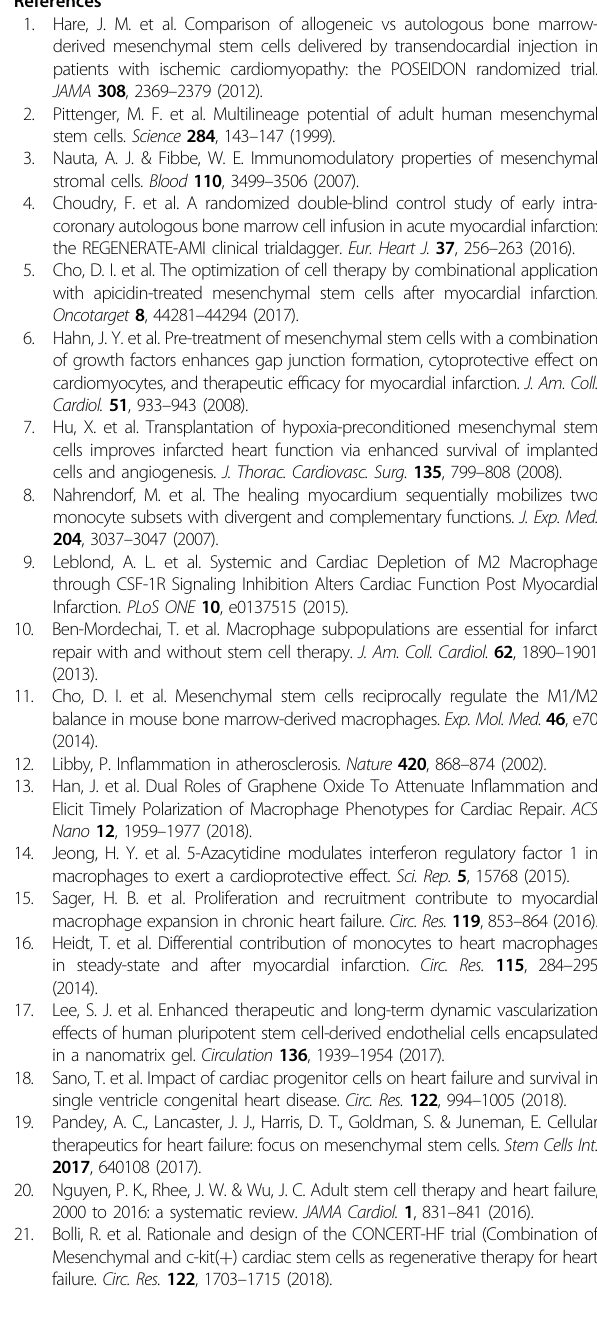
Fig. 7 Schematic representation of the contribution of BMMSC- primed BMDMs to the overall improvement in BMC-induced cardiac